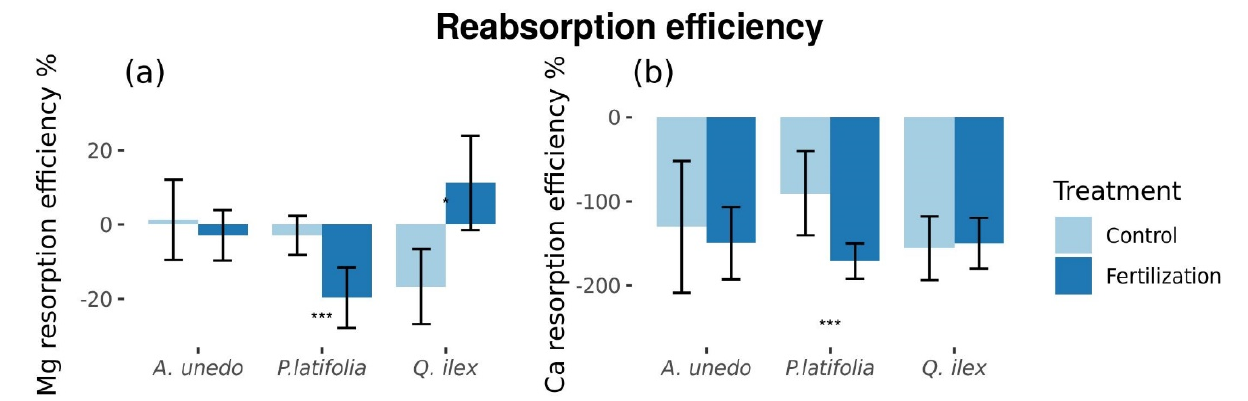
Figure 4. Microelements resorption efficiency % statistically different between control and fertilized plots. ( a ) Mg resorption efficiency. ( b ) Ca resorption efficiency. * = Marginal significance ( p = [0.05, 0.1]). *** = Significant differences ( p < 0.05). Figures with standard error.